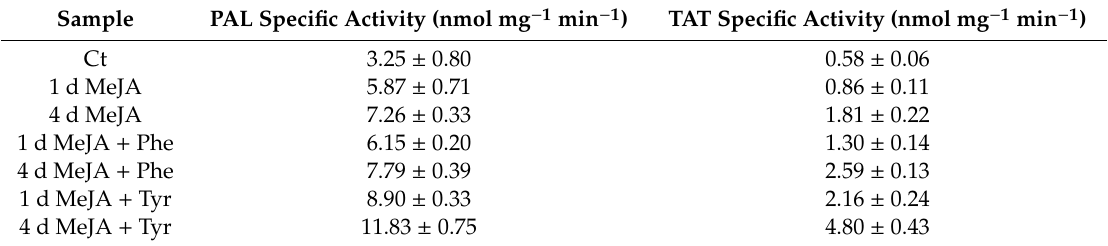
Table 2. Specific activities of phenylalanine ammonia-lyase (PAL) and tyrosine aminotransferase (TAT) of hemp cell extracts before and after di ff erent elicitation